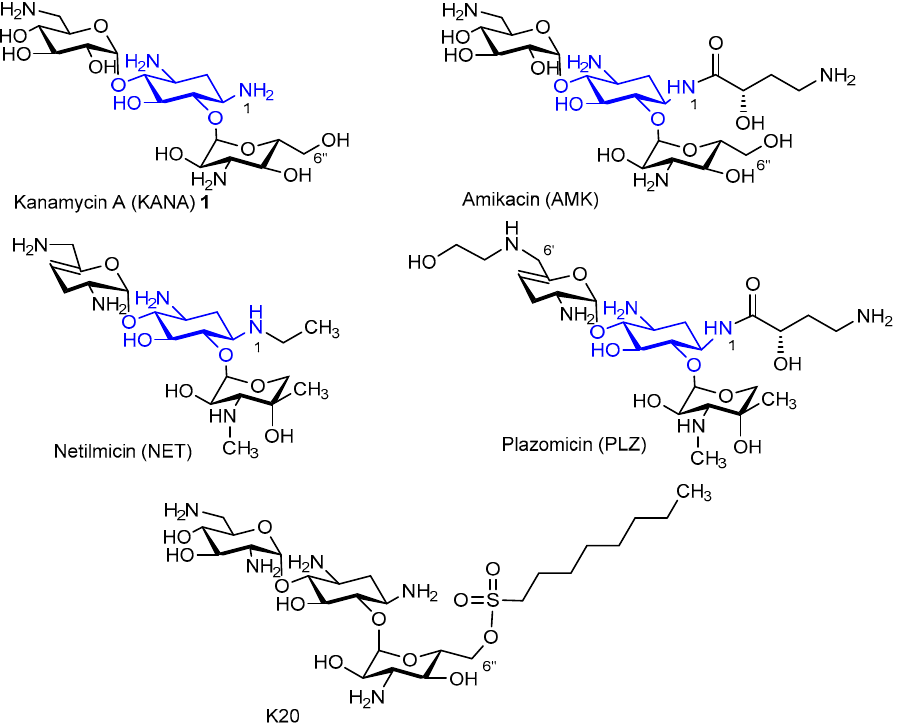
Figure 1. Structures of selected aminoglycoside